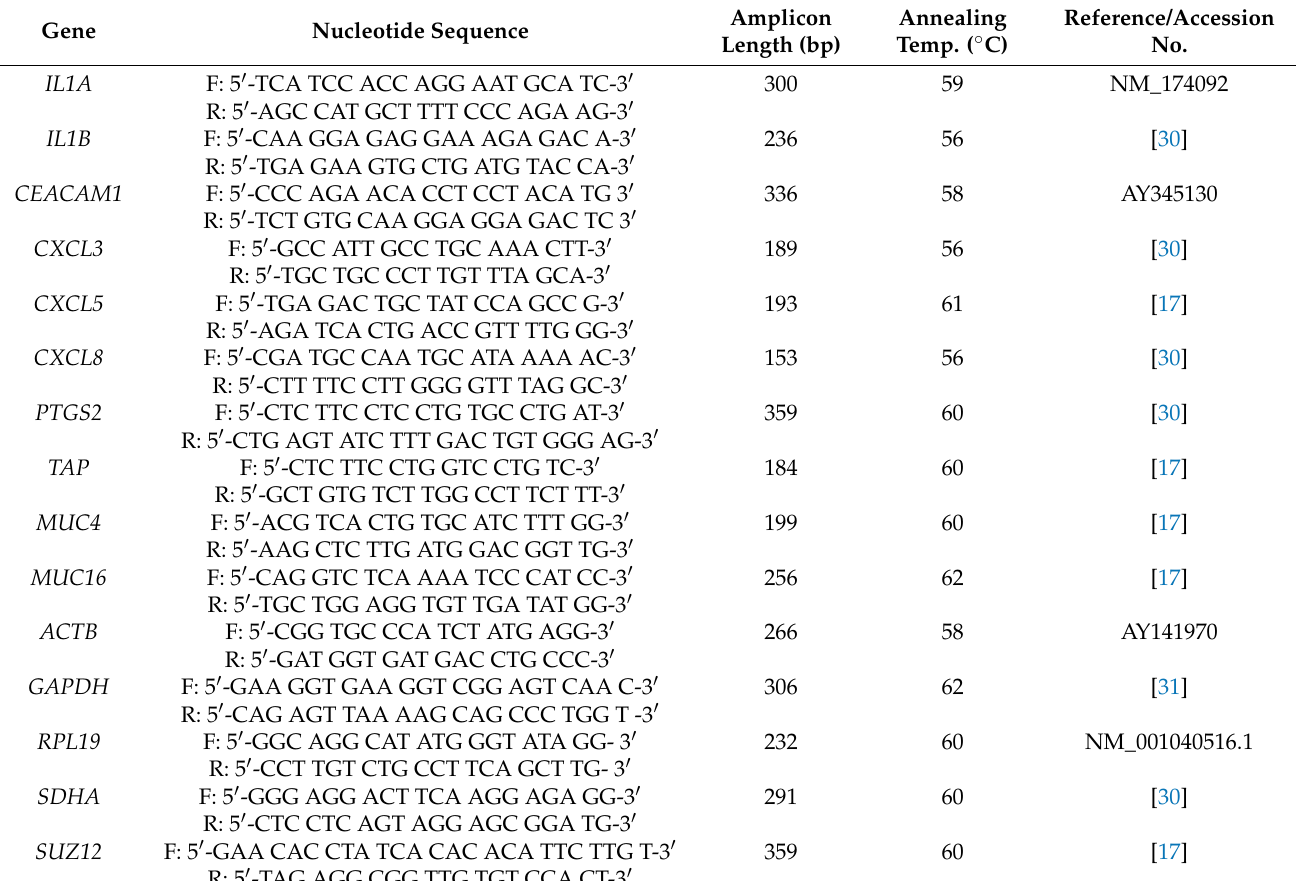
Table 1. Primer sequences, resulting amplicon length, annealing temperatures used for quantitative PCR for selected transcripts and reference